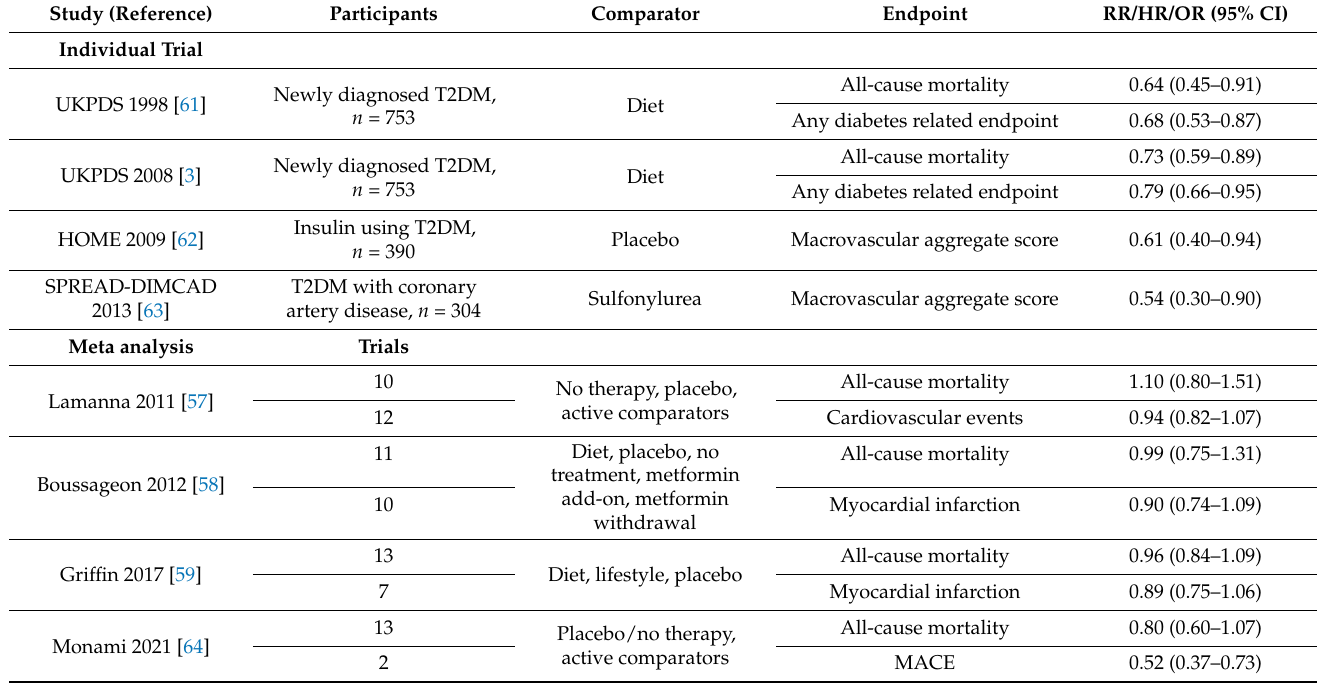
Table 2. Effect of metformin on cardiovascular outcomes in randomized